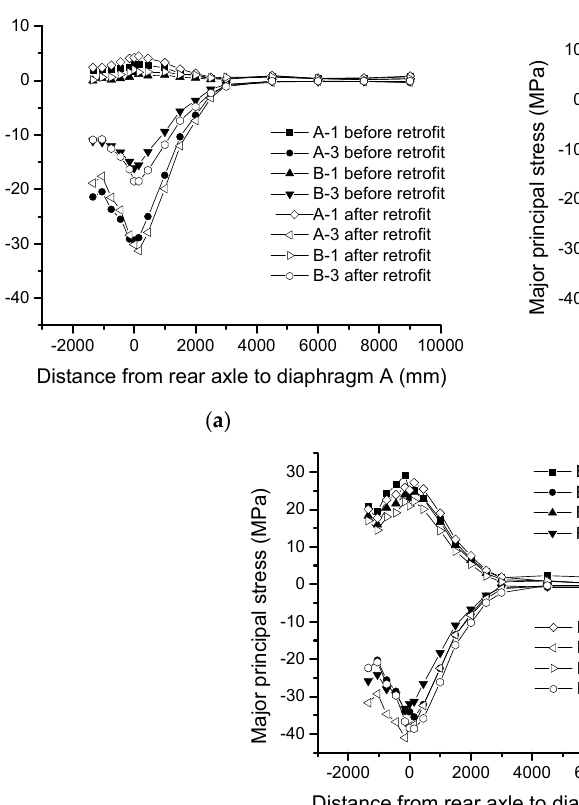
Figure 18. Stress spectra of diaphragm cutouts under lateral moved vehicle: ( a ) stress spectra of zone A, ( b ) stress spectra of zone B.